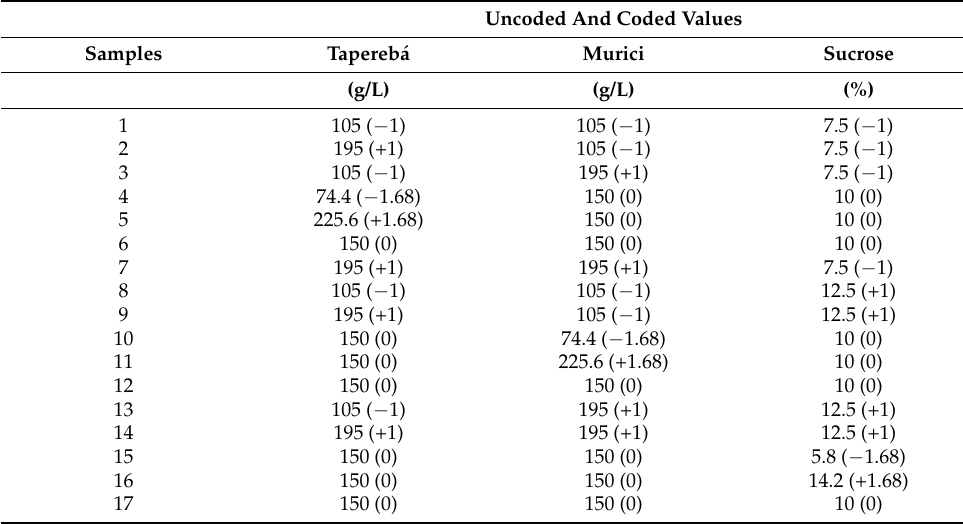
Table 6. Factorial design 2 3 for preparation of murici and tapereb á beverages blends (uncoded and coded